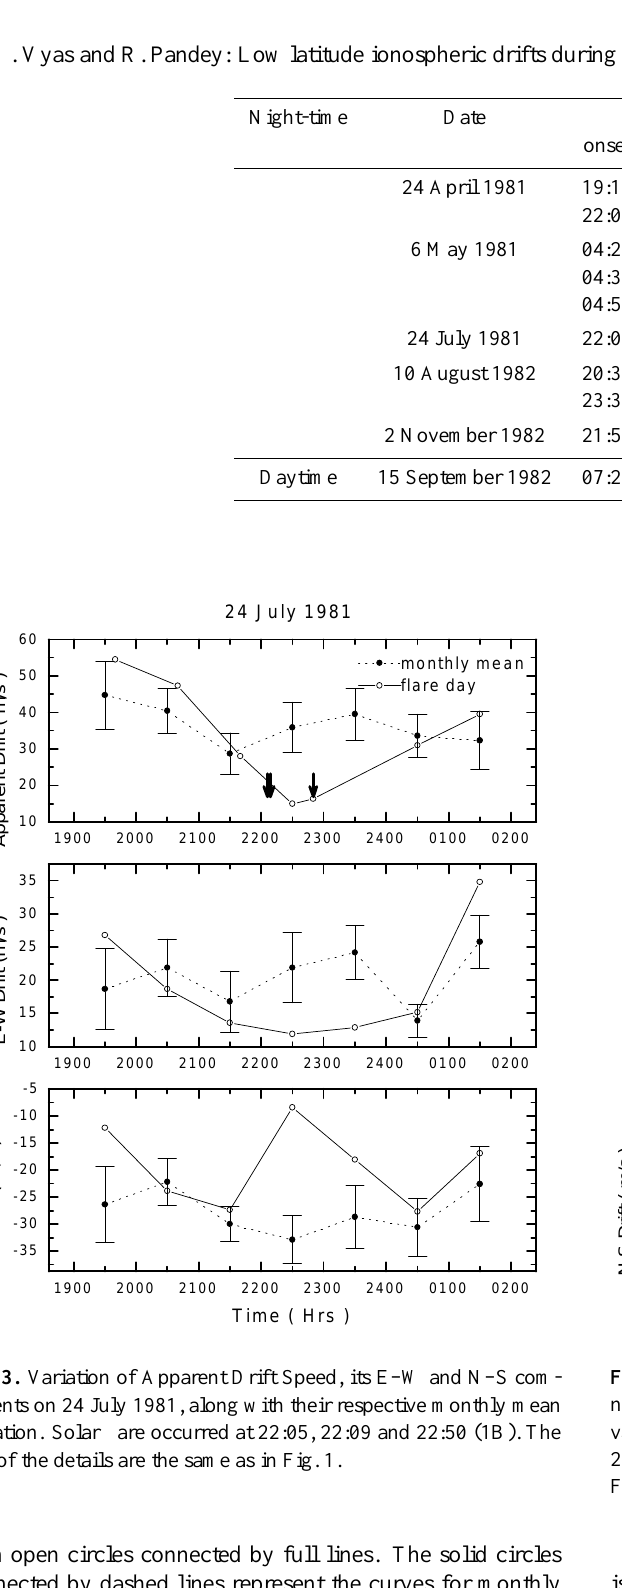
is the abscissa for these curves. The time of occurrence of the solar flares is indicated by downward pointing vectors. Normally, a flare is characterized by three phases, namely, onset, maximum and its end. Thus, the vectors starting from the same ordinate level represent the corresponding phases. Table 1 gives a list of the flare days on which observations are available. The table also gives the period of a flare and its type. On some of the days, more than one flare was